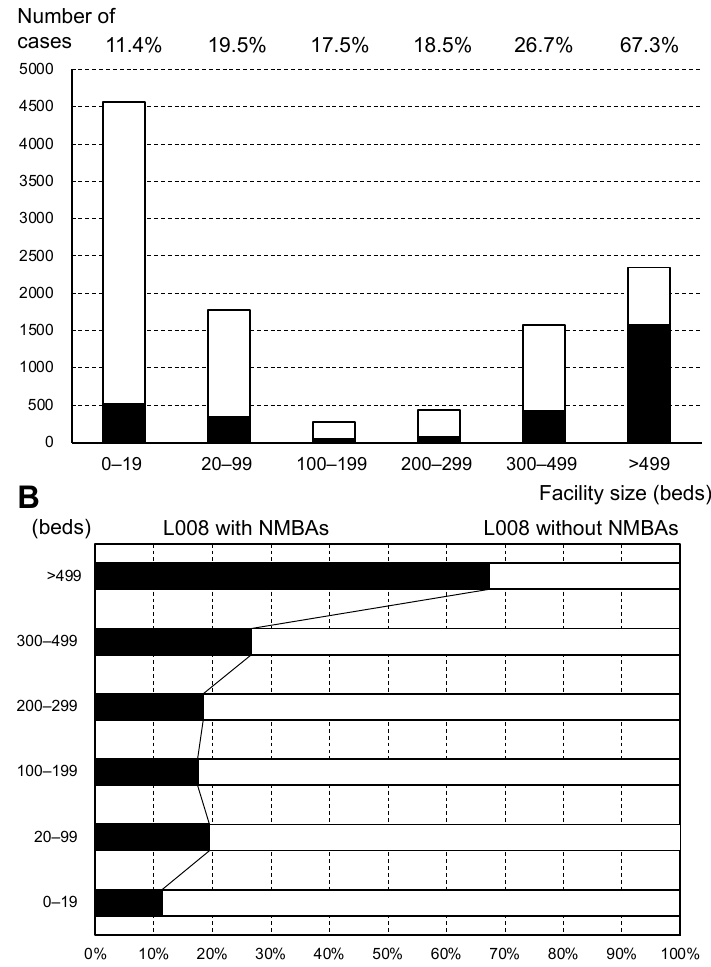
Figure 3. ( A ) The number of general anesthesia claim code (L008) according to facilities with different bed sizes. The black bar indicates the number of cesarean deliveries receiving NMBAs during general anesthesia. ( B ) The percentage of L008 with and without neuromuscular blocking agents (NMBAs) according to the facilities with different bed sizes.